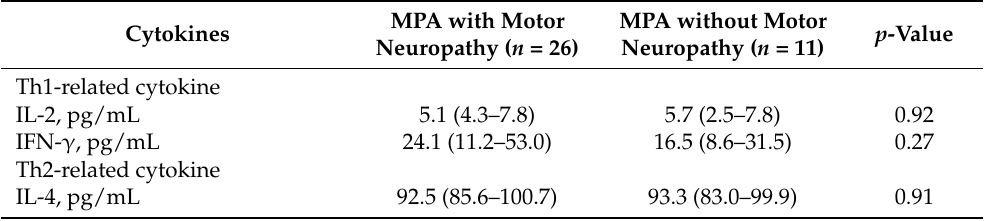
Table 5. ComparisonofthecytokinelevelsbetweenpatientswithMPAwithandwithoutmotor